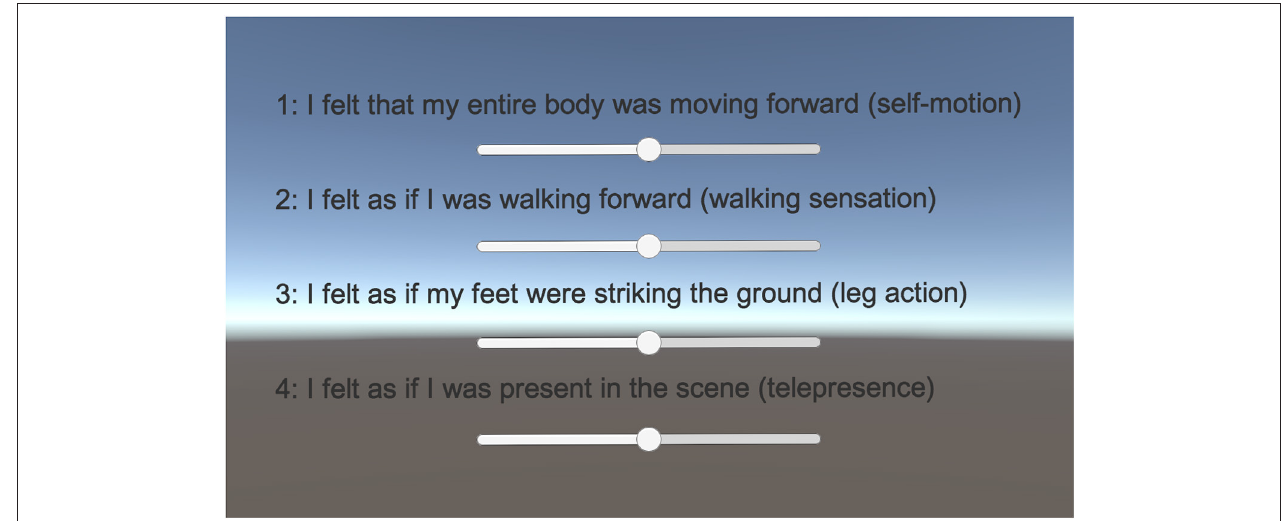
FIGURE 5 | Visual analog scale (VAS) response screen of the experiment.